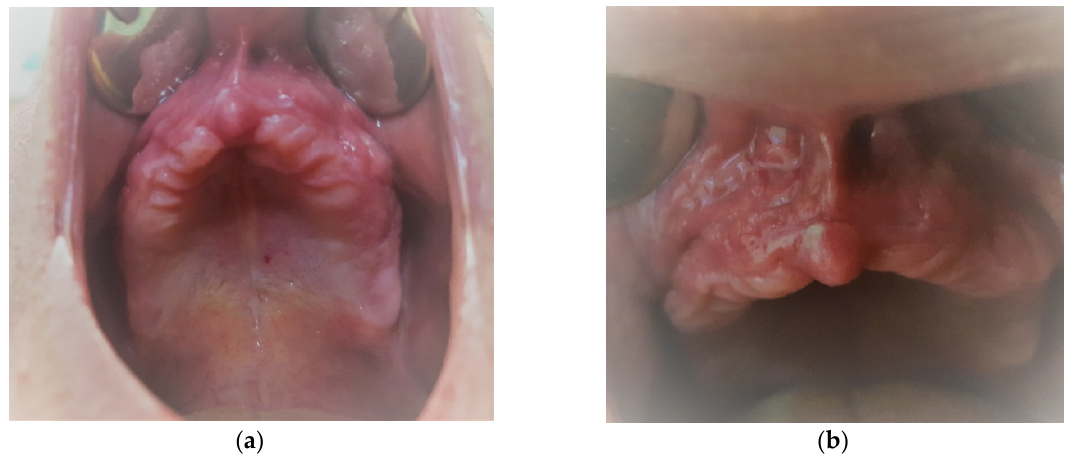
Figure 1. ( a ) Fronto-lateral, hypertrophied, hyper keratinized flabby ridge, with high antero-posterior mobility, large thickness, rhomboidal incisive papilla, “drop” appearance, low-insertion labial frenum, deep palatal arch in the anterior portion, neutral tuberosities, ah oblique zone; ( b ) detail of the appearance of the flabby ridge; the arrows indicate the height of the layer of flabby mucosa.